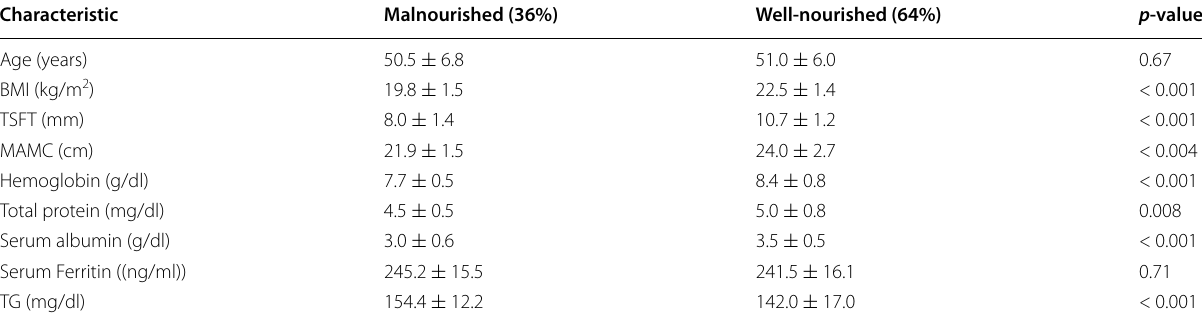
Table 4 Distribution of anthropometric and laboratory parameters between well-nourished and malnourished CKD patients with eGFR > 30 ml/min/1.73m 2